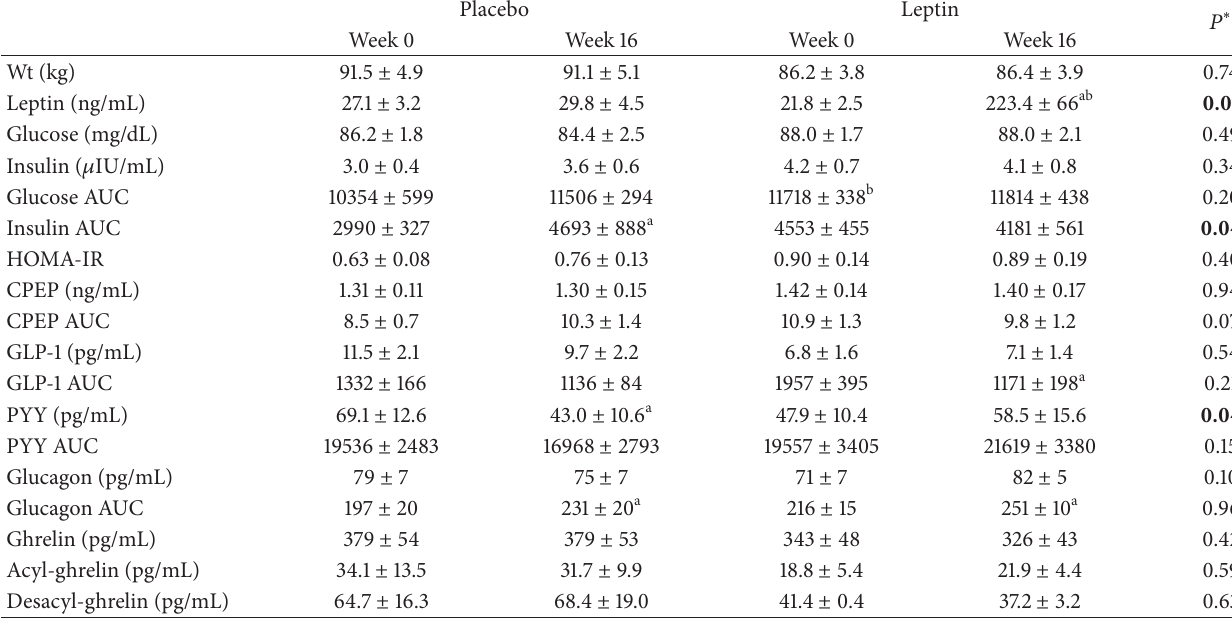
Table 2: Changes in weight, glucostatic, and appetitive hormones.